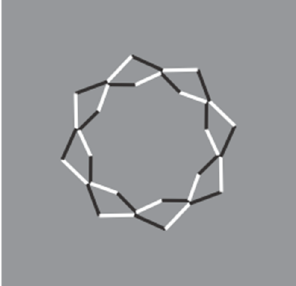
Figure 10. An intertwined flower-like spiral.